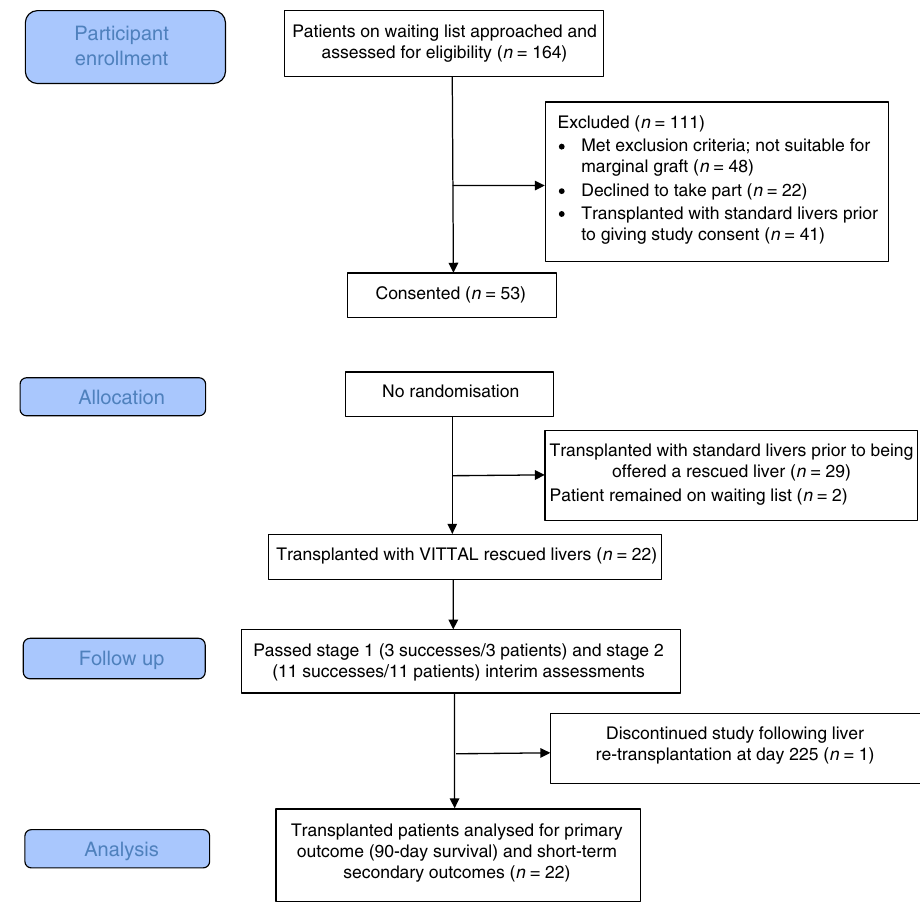
Fig. 2 CONSORT fl ow diagram displaying the progress of patients through the trial. One hundred and sixty-four patients on the waiting list were approached for potential trial participation. Of those, 111 were excluded; 48 patients met exclusion criteria and were not suitable for a marginal liver graft. Twenty-two patients declined to take part and 41 patients either received a transplant before they provided study consent, or were de-listed, or subsequently met exclusion criteria. Eventually 53 patients consented to the study, of which 29 underwent transplantation with a standard quality liver allocated outside the trial. Twenty-two patients were enroled in the trial and received a salvaged